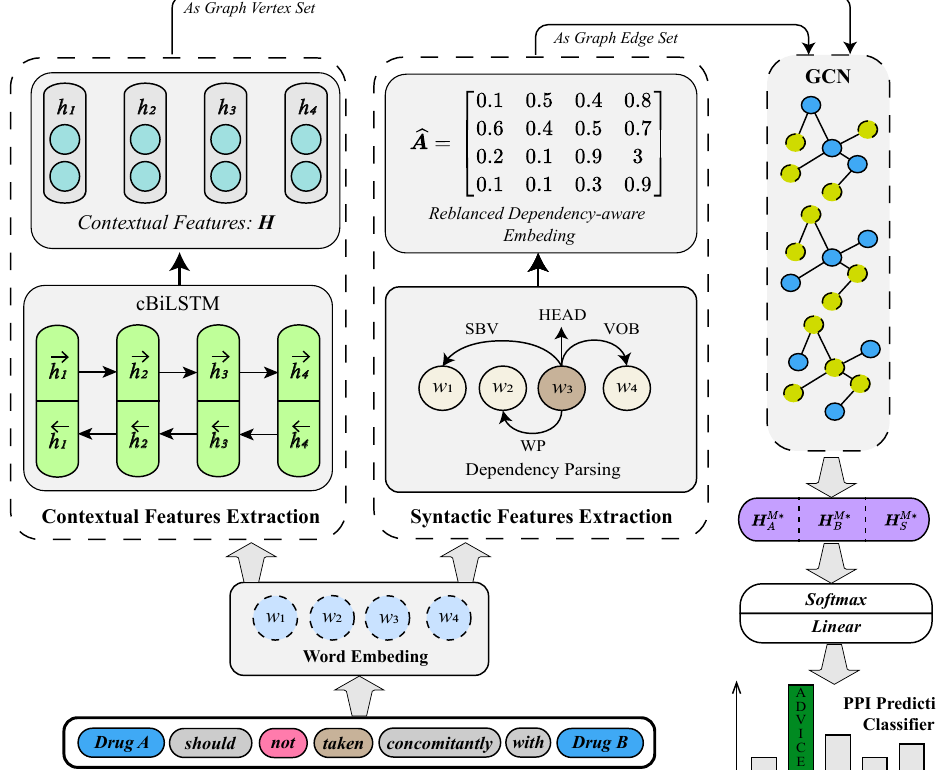
Figure 2. Architecture overview of our proposed DDINN